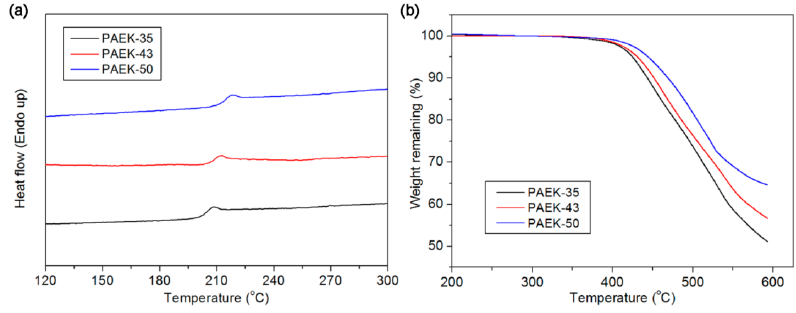
Figure 3. ( a ) DSC and ( b ) TGA curves of PAEKs.